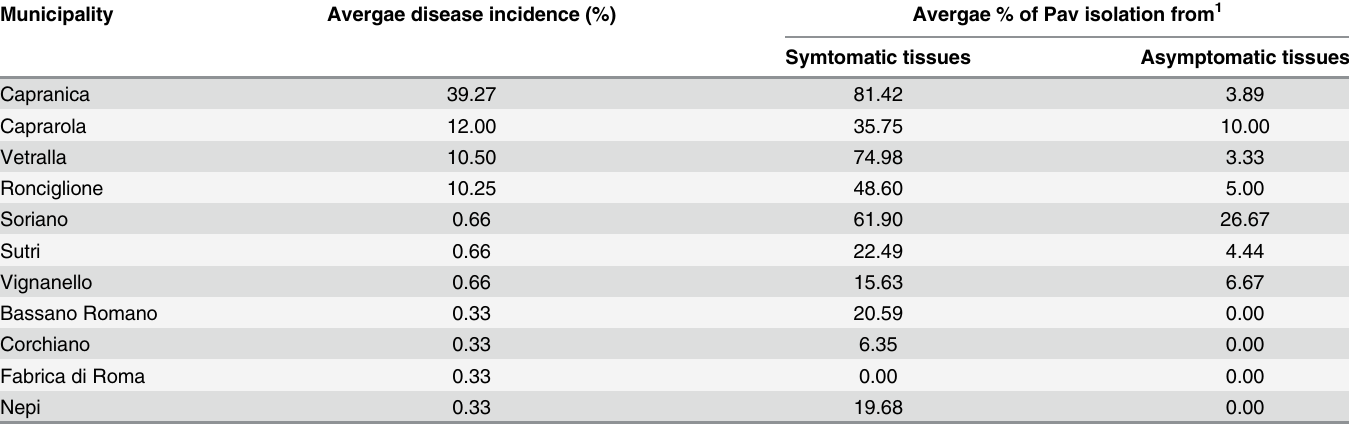
Table 1. Isolation of Pseudomonas avellanae (Pav) from hazelnut twigs collected from 2010 to 2012. Samples were collected from March to August, each year. The average percentage of Pav isolation for the three years is calculated by the ratio between the number of Pav-positive samples and the total number of samples used for